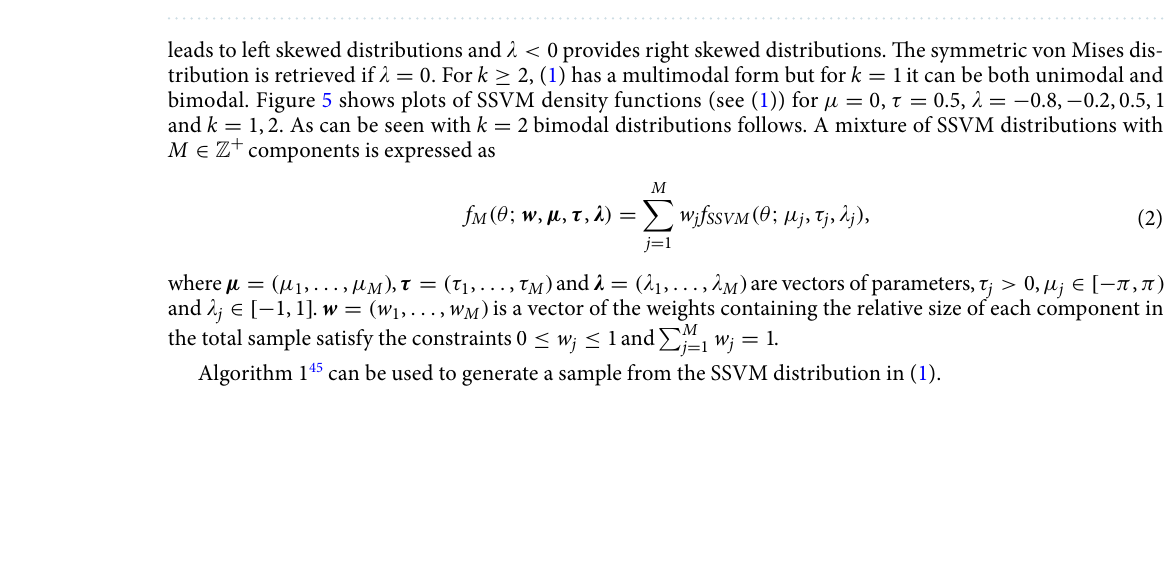
Figure 4. Boxplots and kernel density plots of the wind direction datasets A-C from Marion island, Jeffreys Bay and Noupoort wind